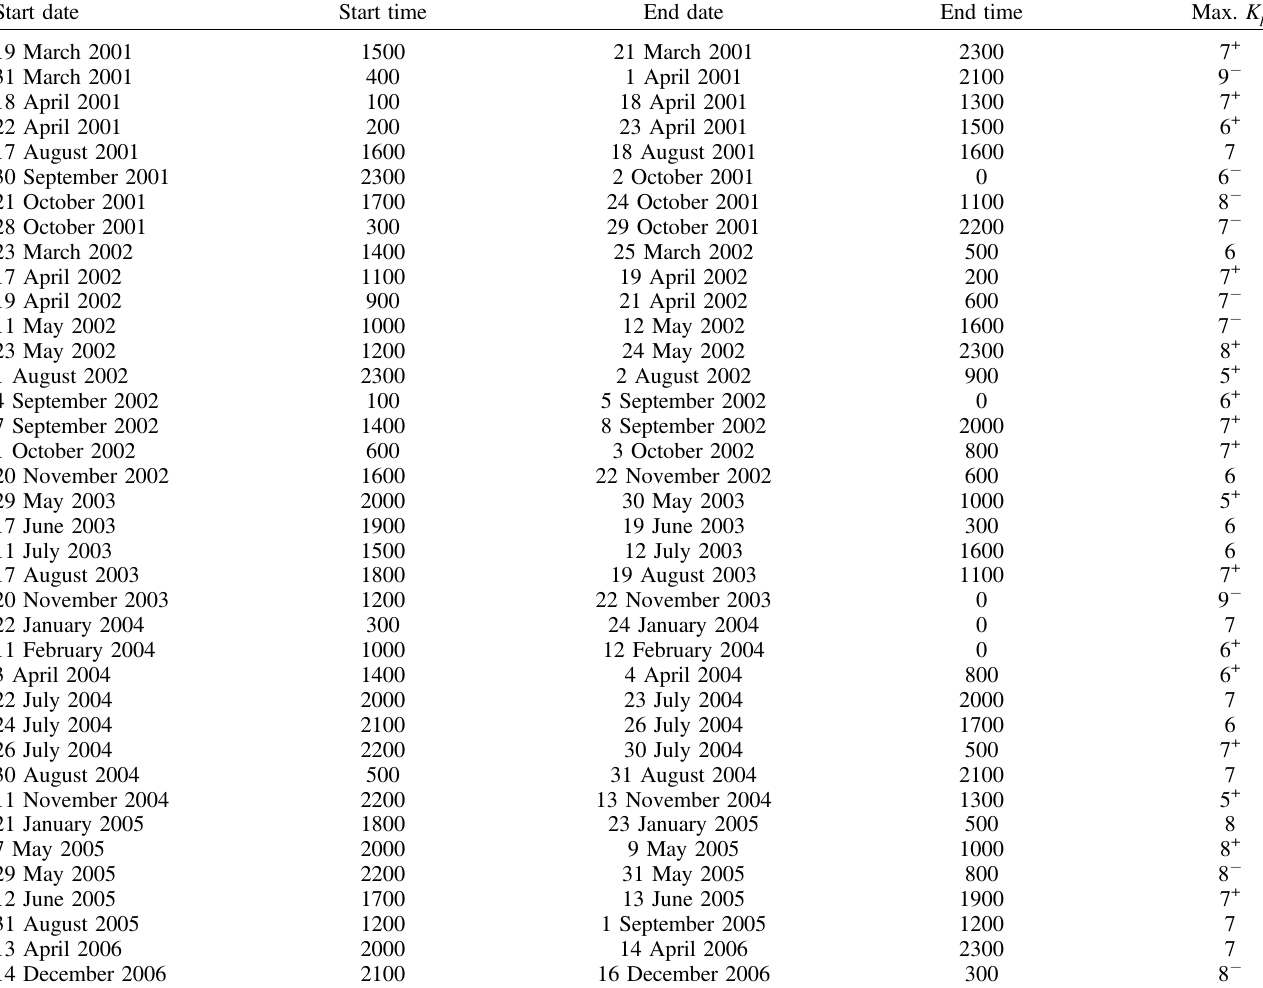
Table 3. List of storm